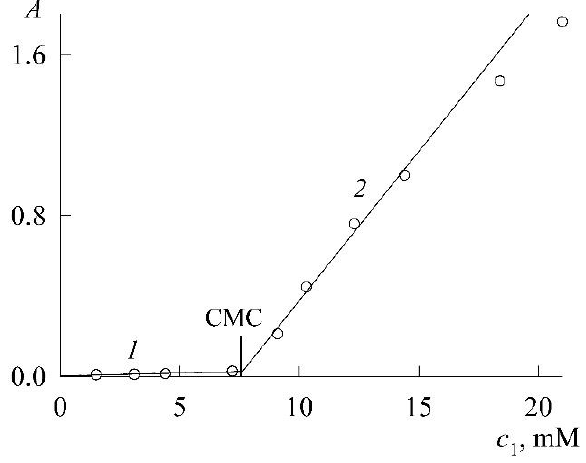
Figure 4. Dependence of the optical density ( A ) of saturated NR solutions on the SDS concentration ( c 1 ).